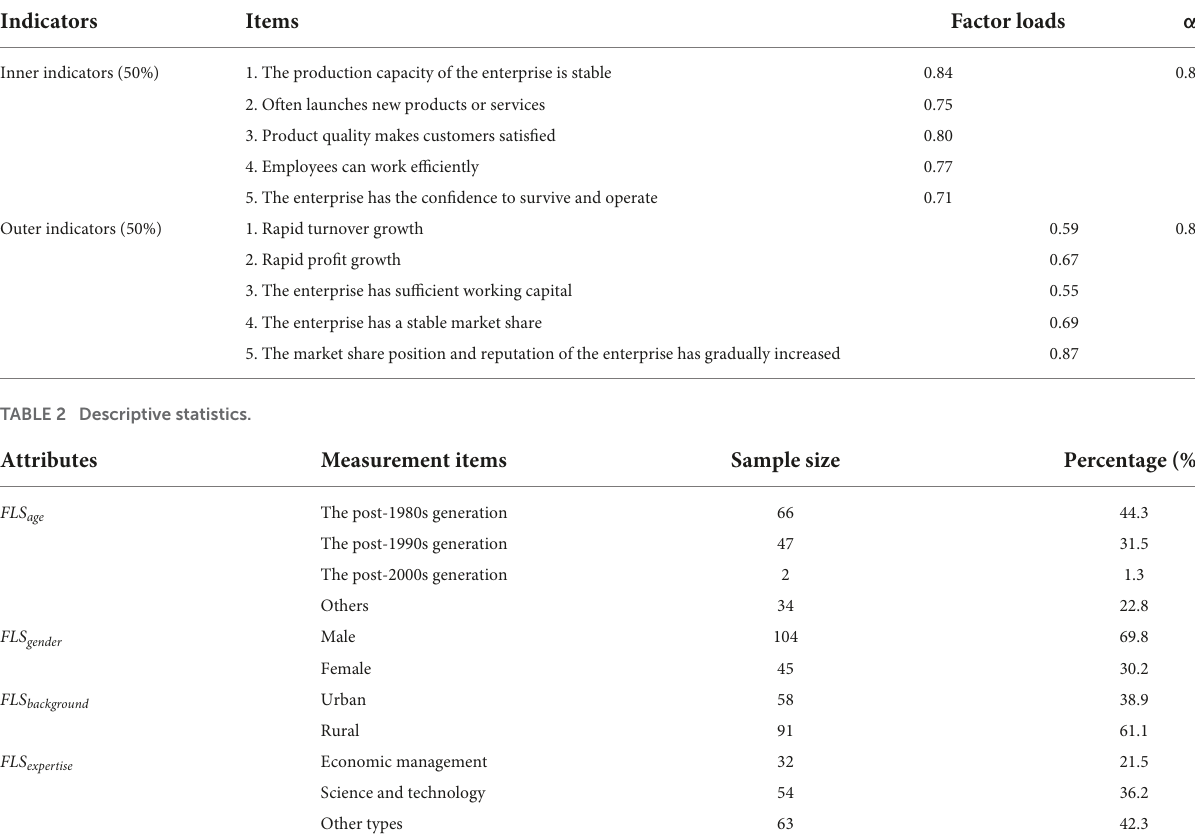
TABLE 1 Performance measurement scale of returning entrepreneurial